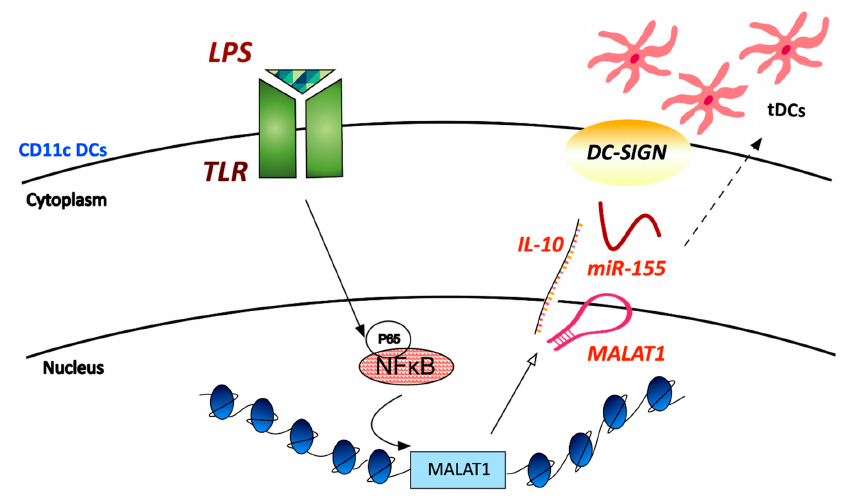
Figure 3. Expression of MALAT1 is increased in response to inflammatory stimuli in CD11c + cells of tolerized allograft cardiac tissue. LPS-induced transcription of MALAT1 was shown to be dependent on the p65- associated activation of the NF- κ B pathway and to increase secretion of the immunosuppressive cytokine IL-10. DC-SIGN (dendritic cell- specific intercellular adhesion molecule-3 grabbing nonintegrin) was also shown to be controlled by MALAT1 and to act as a miR-155 sponge to maintain the tolerogenic ability of the tDCs (tolerogenic DCs).